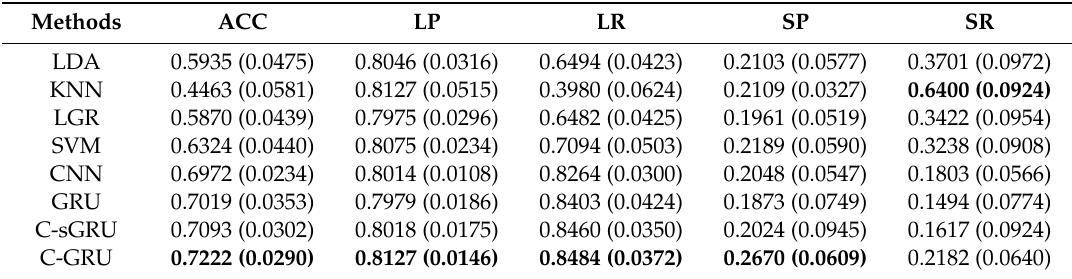
Figure 5. Classification results using independent component time series. Convolution-GRU achieved the highest classification accuracy rate of 72.2%, while traditional classifiers performed poorly, and none exceeded65%. Deeplearningmodelsperformedsimilarlyinthemajorityclass,however,convolution-GRU performed best in the minority class. Table 1. Performance of the methods in IC